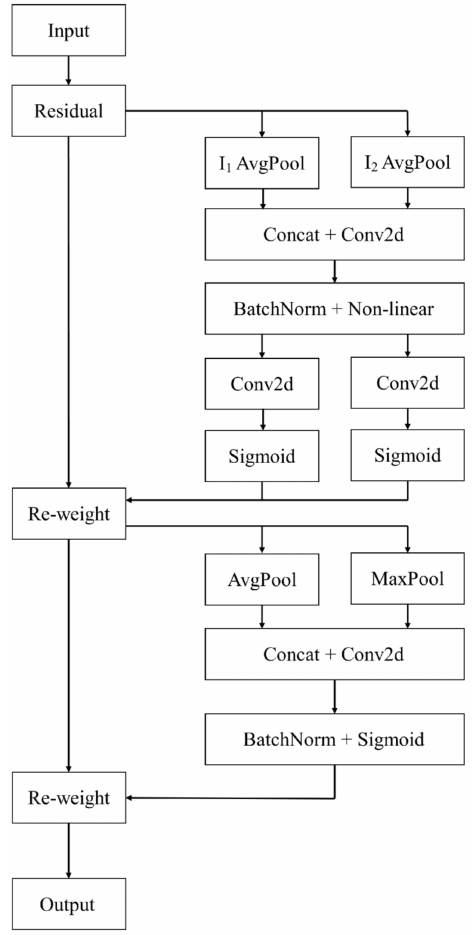
Figure 6. The schematic diagram of CS 2